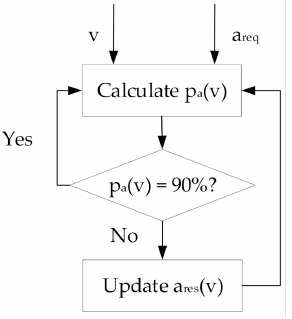
Figure 9. Acceleration reserve adjustment